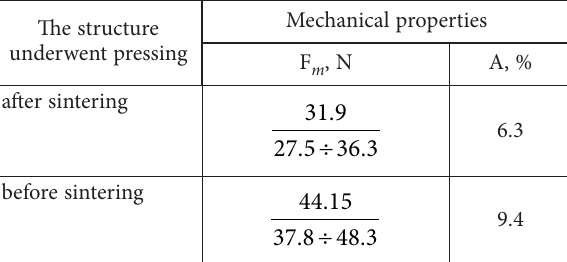
Table 1. Mechanical properties of porous structure before and